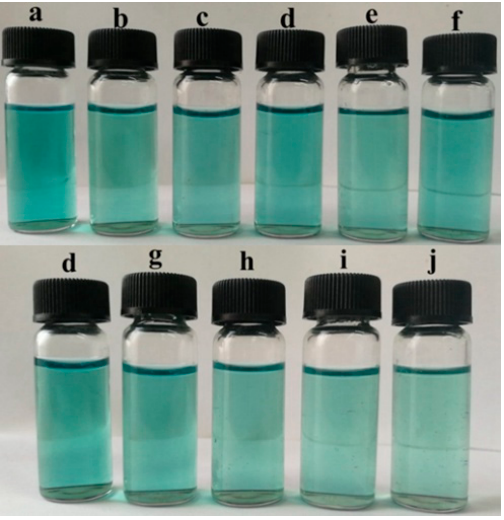
Figure 10. Pictures of ABTS radical scavenging activity. ( a ) ABTS solution; ( b ) control film; ( c ) 1% TiO 2 -N; ( d ) 3% TiO 2 -N; ( e ) 5% TiO 2 -N; ( f ) 7% TiO 2 -N; ( g ) 3% CO-3% TiO 2 -N; ( h ) 6% CO-3% TiO 2 -N; ( i ) 9% CO-3% TiO 2 -N; and ( j ) 12% CO-3% TiO 2 -N.